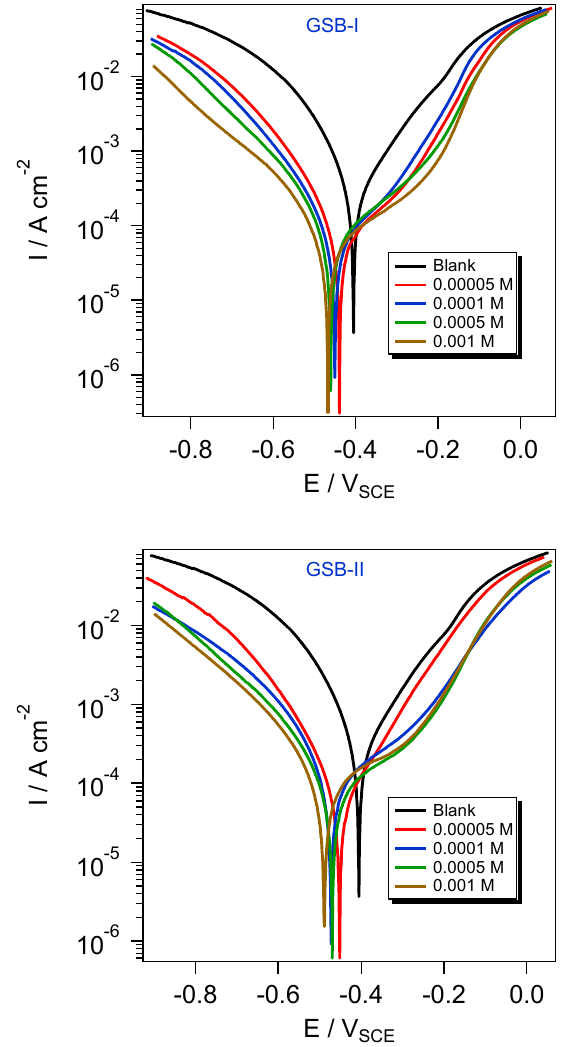
Figure 4. Polarization curves for the API 5L X65 steel in 1 M HCl medium with different concentra- tions of the studied inhibitors at 298 K. Table 1. Tafel factors for the API 5L X65 steel corrosion in 1 M HCl without and with different concentrations of studied inhibitors at 298